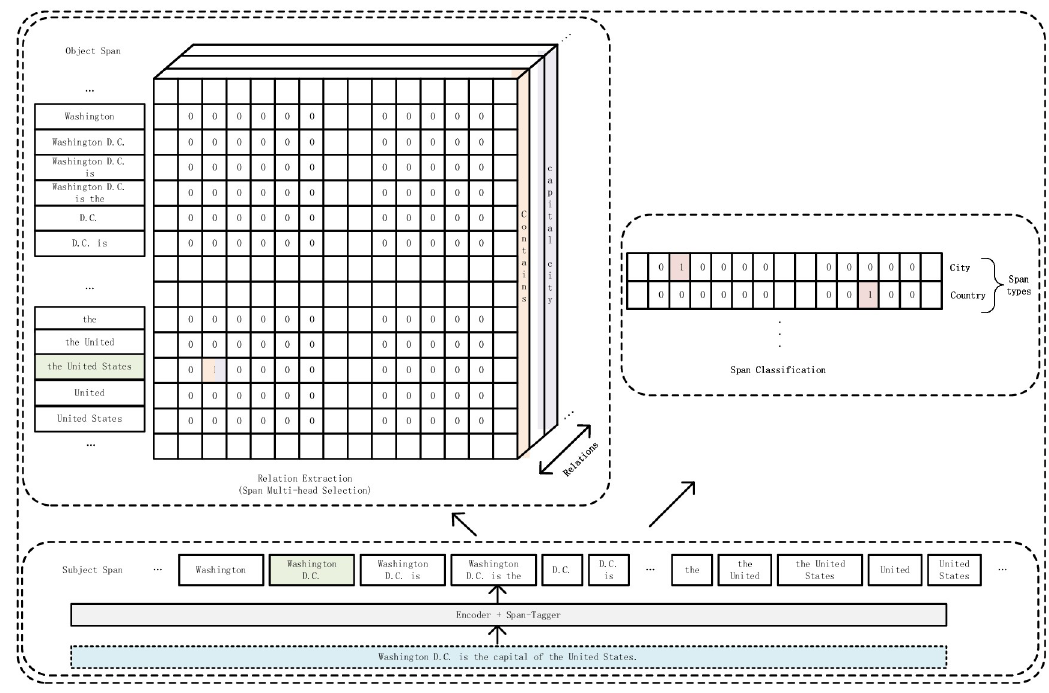
Fig 3. Example of decoding process (window length is 4). On the left is the decoding of relation extraction, and on the right is the decoding of span classification. The left three-dimensional matrix row is the index of the subject, the column is the index of the object, and the side surface is the index of the relationship.A cell with a value of 1 in the matrix represents a triple of subject, object and relationship corresponding to its coordinates. For example, the triples in the figure are (the United States, contains, Washington D.C.) and (the United States, capital city, Washington D.C.).